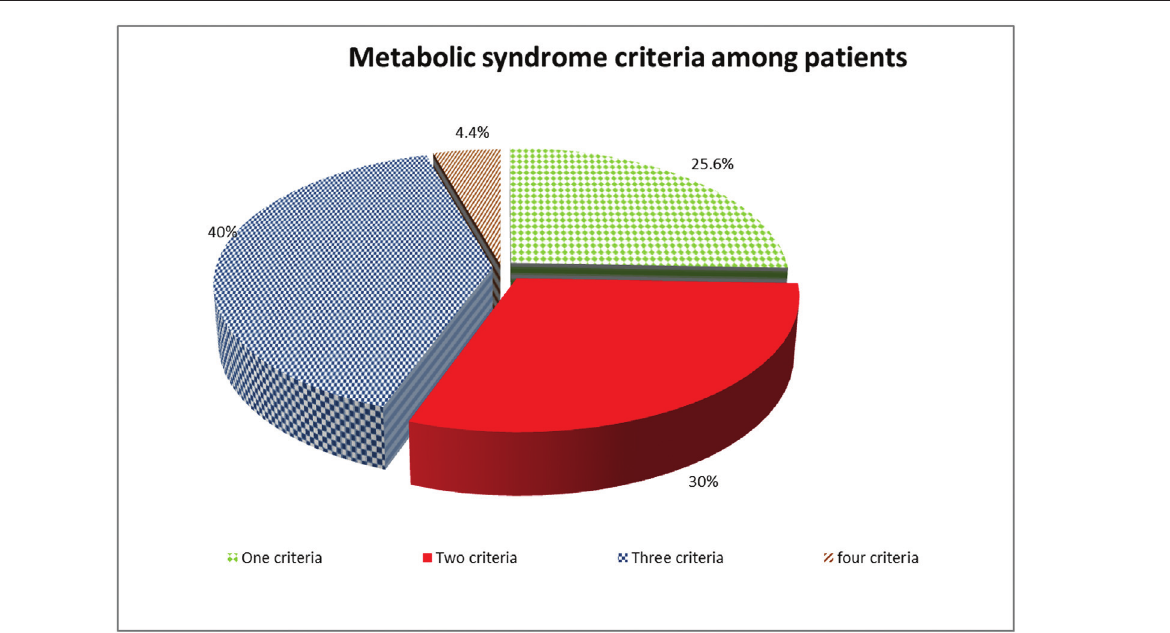
Metabolic syndrome criteria among patients with chronic obstructive pulmonary disease.